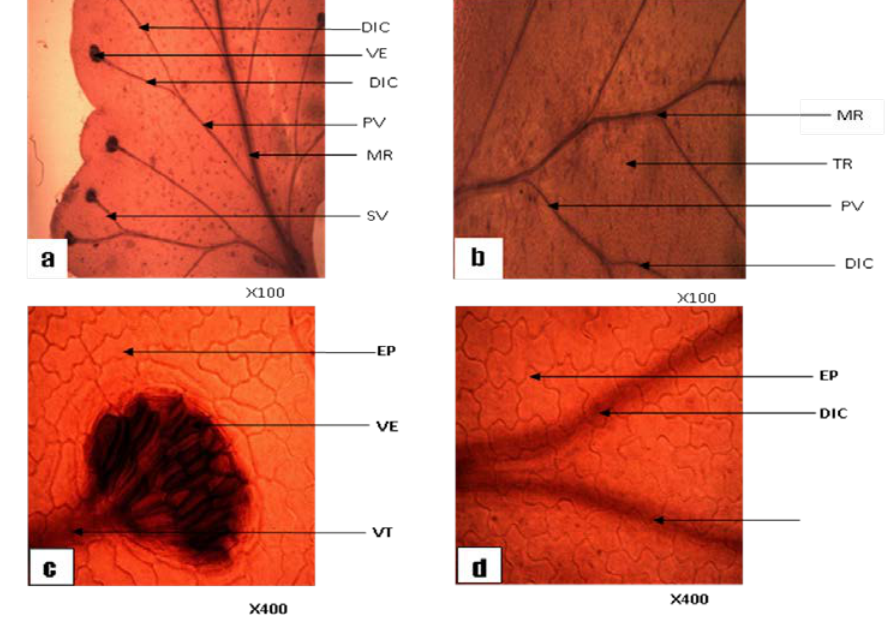
Fig. 3. Venation pattern of the leaflet of N . exalta